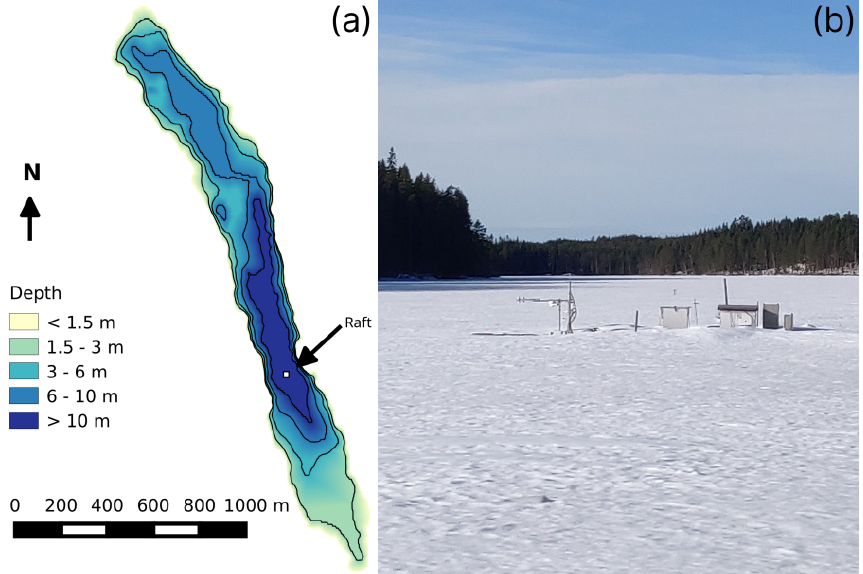
Figure 1. Bathymetric map of Lake Kuivajärvi with the position of the EC raft shown as a white square (a) . Photo (b) shows the raft as it stood in March 2021. Map adapted from Erkkilä et al. (2018). Table 1. Ice-on periods at Lake Kuivajärvi used in this study (2014–2019) and the corresponding number of 30min EC flux values used in this study. Period No. of 30min